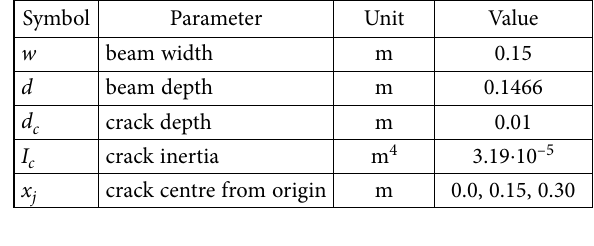
Figure 13. Christides and Barr (1984) crack modelling using exponential function